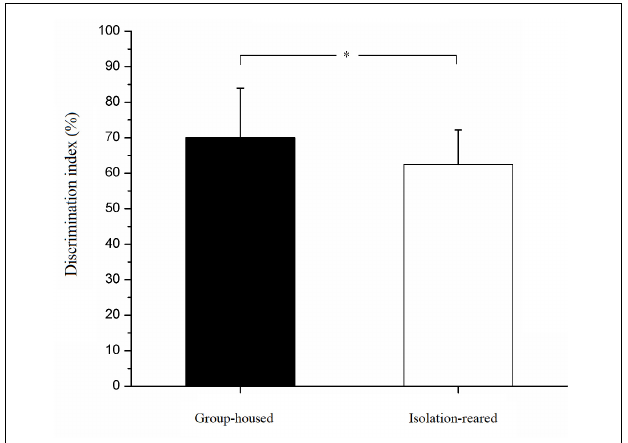
FIGURE 2 | Discrimination index of isolation-reared and group-housed mice in the social recognition tests. ∗ Indicate p < 0.05. Bar represent mean. Error bar represent